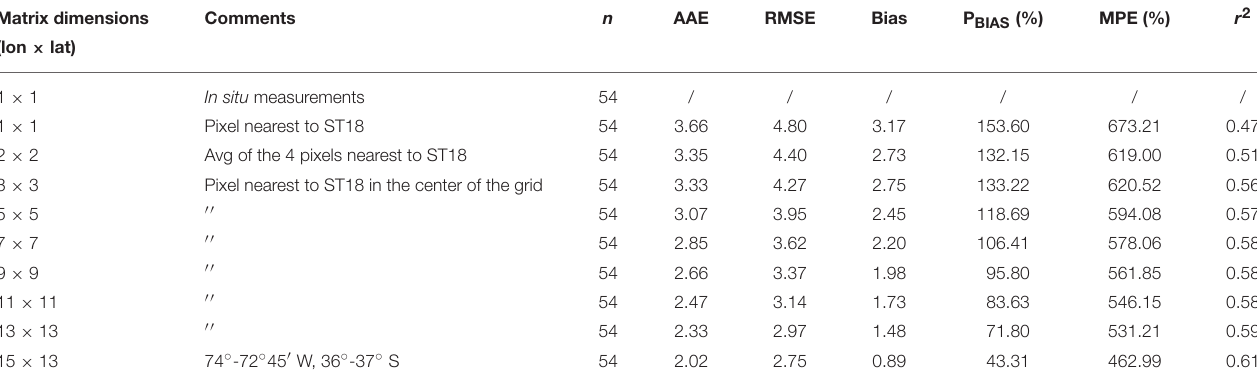
TABLE 1 | Summary of error statistics, i.e., Absolute Average Error (AAE), Root Mean Square Error (RMSE), Bias Mean Normalized Bias (P BIAS ), Mean Absolute Percentage Error (MPE) and r 2 coefficients for different satellite NPP areas. Matrix